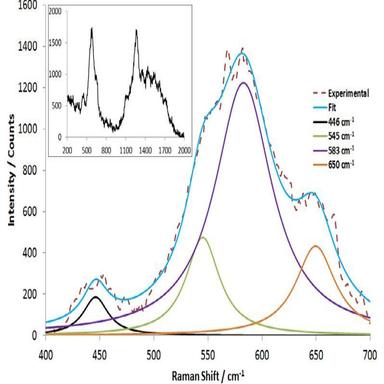
μRaman spectra of an area on the edge of a (Ba,Sr)ZrO3 precipitate phase in a 43 GWd/tU AGR SIMFuel sample (inset) and profile analysis over the range of 400–700 cm−1 (main).